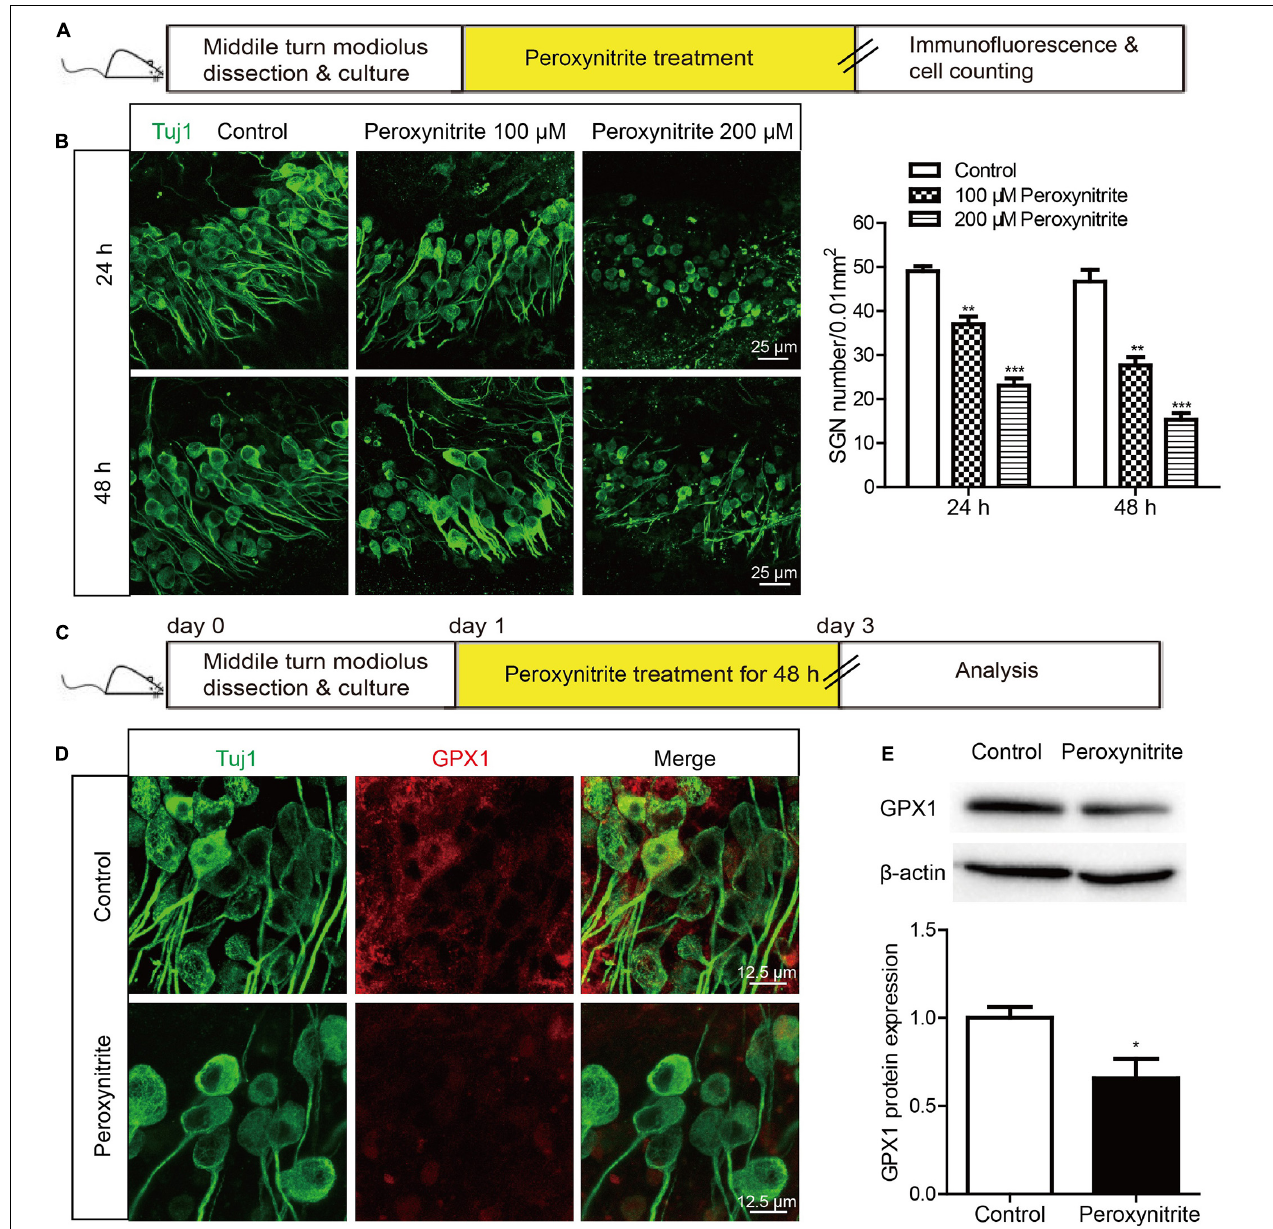
FIGURE 2 | The expression of GPX1 is decreased in cochlear SGNs after peroxynitrite injury. (A) The cultured SGNs from WT C57BL/6 mice were treated with different concentrations (100 or 200 µ M) of peroxynitrite for 24 or 48 h, respectively. (B) Immunostaining images showed that the SGN morphology was disrupted, cells arrangement was disordered, and nerve fibers were disordered or lost after peroxynitrite administration. Quantitative analysis verified that the numbers of survived SGNs were reduced significantly in peroxynitrite-treated groups in a dose- and time-dependent manner compared with the control group. Scale bar = 25 µ m. (C) The cultured SGNs were exposed to 100 µ M peroxynitrite for 48 h. (D) Immunostaining illustrated that the fluorescence intensity of GPX1 in peroxynitrite group was significantly reduced compared with control group. Scale bar = 12.5 µ m. (E) Western blot showed that the protein level of GPX1 was significantly decreased in peroxynitrite group compared with the control group. * p < 0.05, ** p < 0.01, and *** p < 0.001, n = 3 for each group.